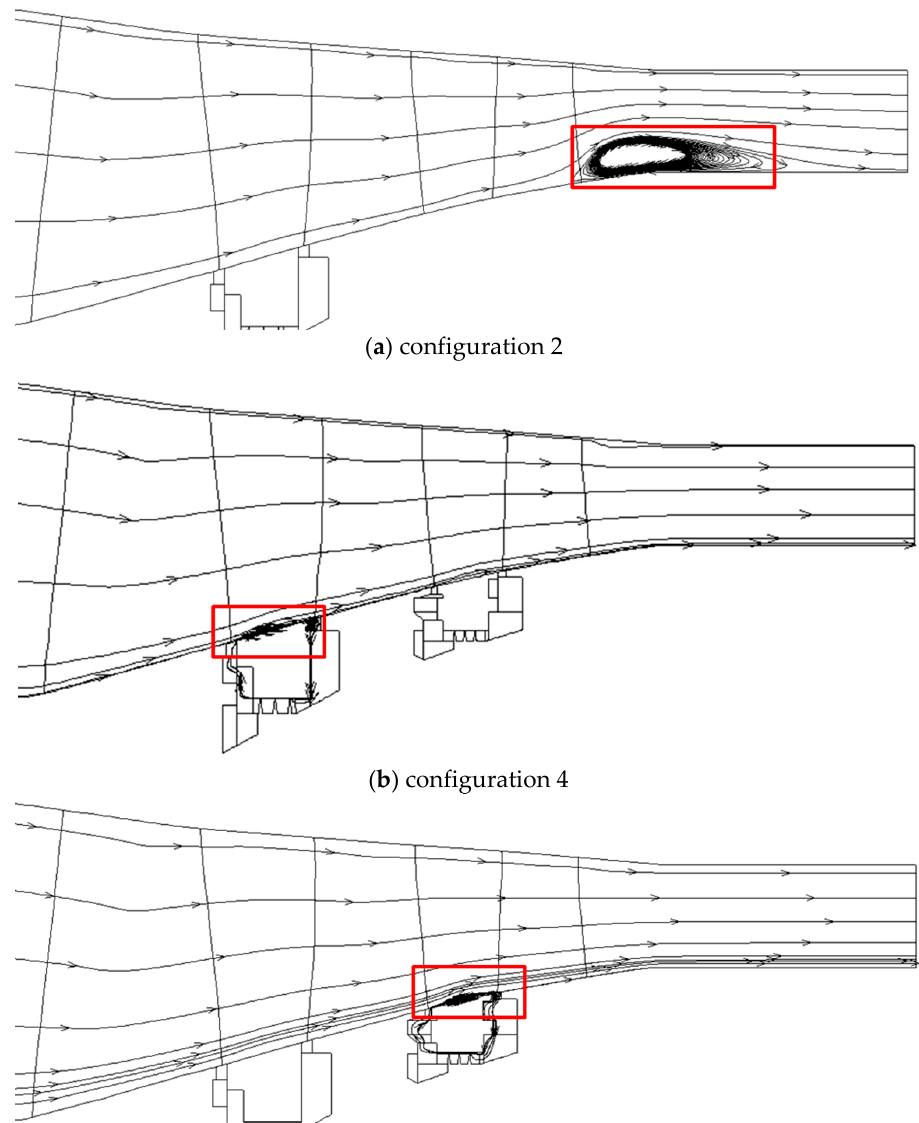
Figure 10. Streamlines at near-stall point for 3 different configurations.